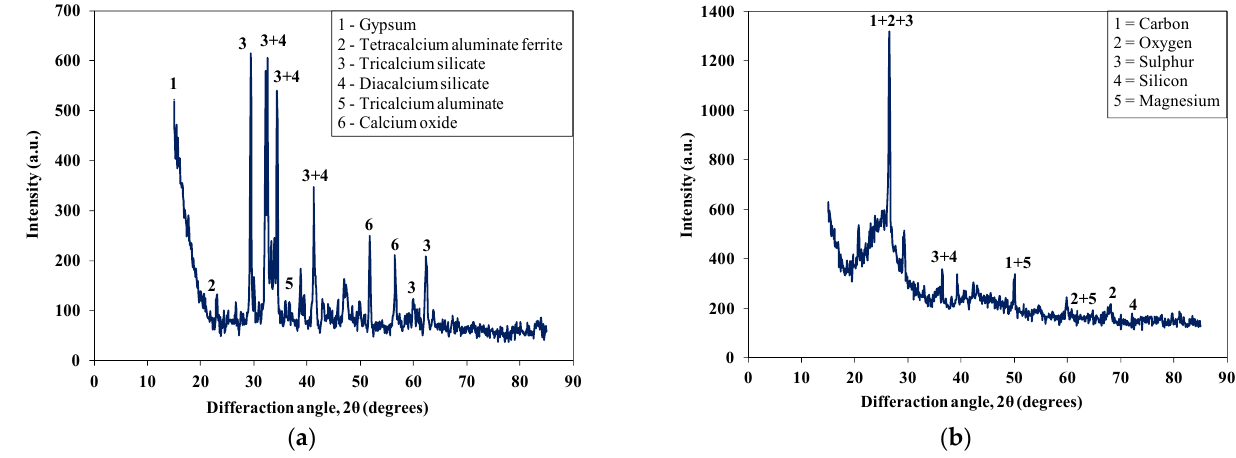
Figure 5. XRD patterns of raw materials. ( a ) Cement; ( b ) Rubber waste. Table 5. Physical properties of cement and recycled rubber waste.